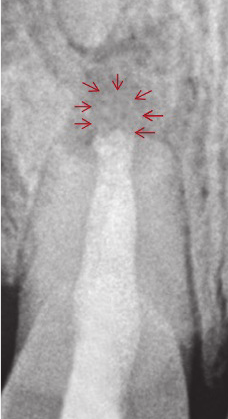
Figure 4: Silhouette of the resorbed suture material when the image is zoomed in to 140%.